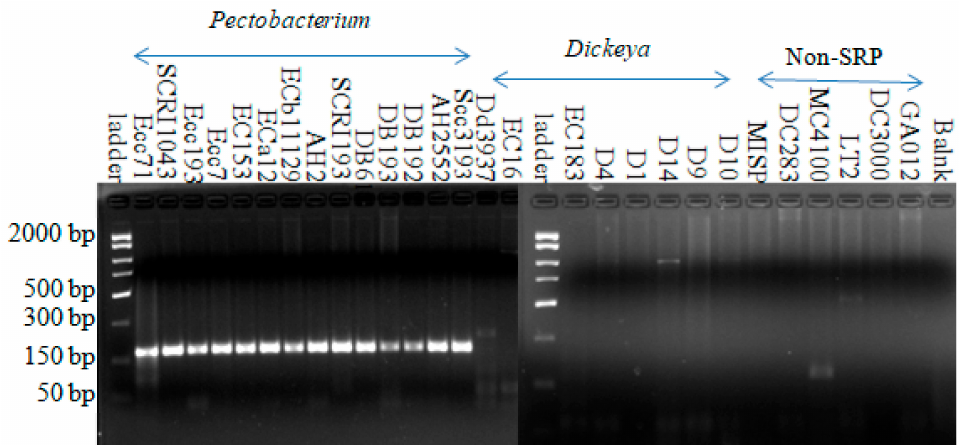
Figure 2. Amplification with Pectobacterium -specific primer (Pcc3F-Pcc3R) from all Pectobacterium strains yielded a product with the expected size around 177 bp. Fifteen microliter reactions were carried out in 45 cycles with annealing at 49.9 ◦ C for 1 min and an extension at 72 ◦ C for 1